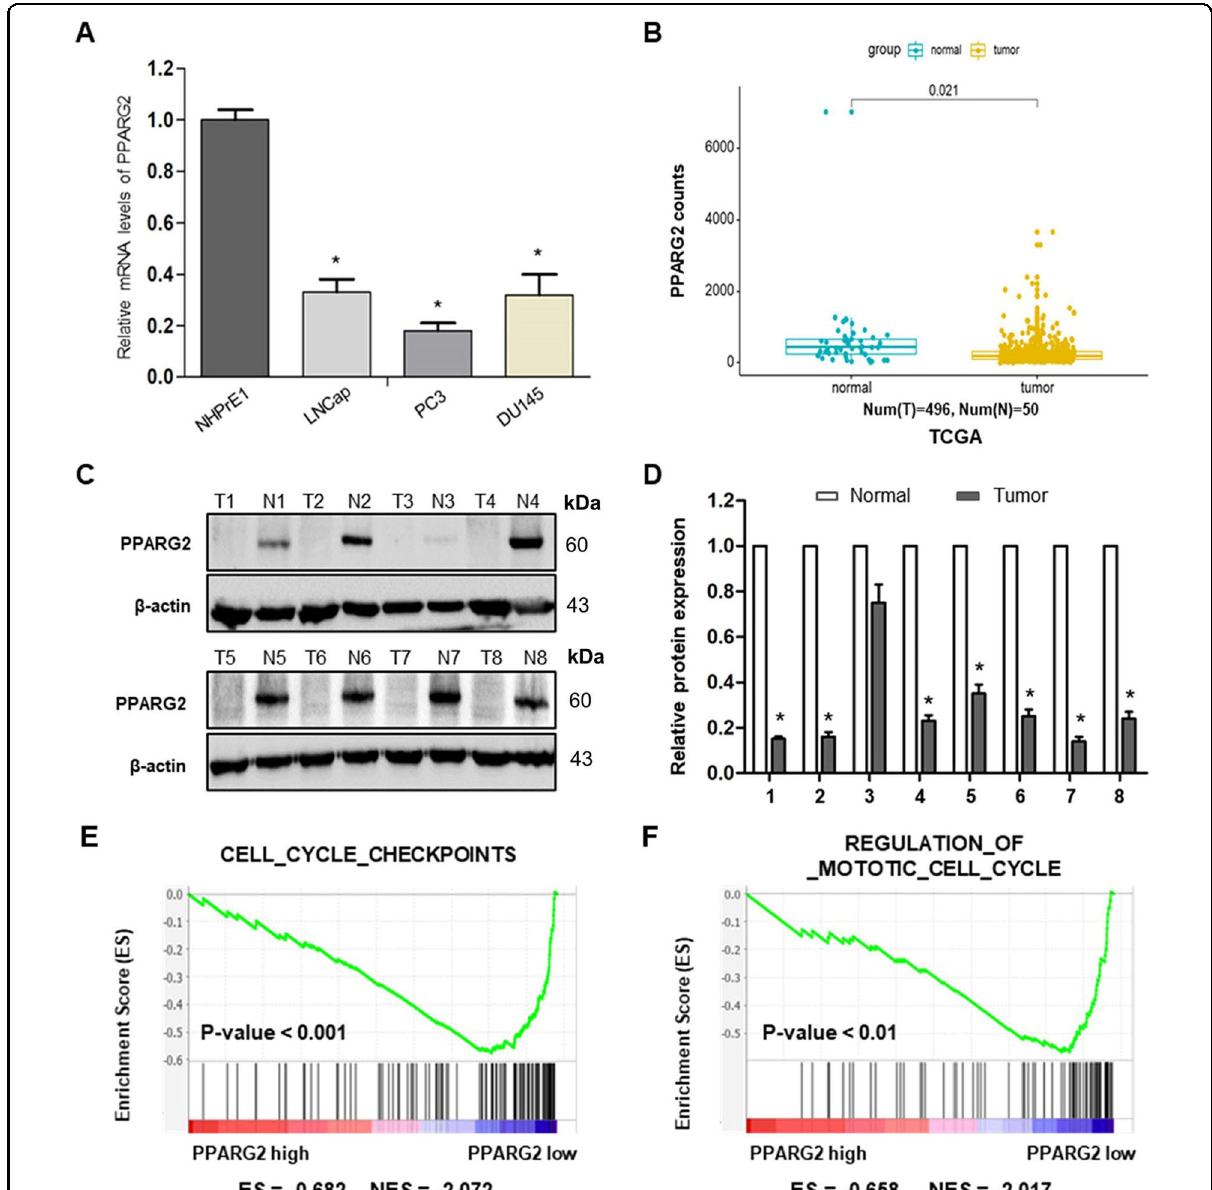
Fig. 1 PPARG2 is downregulated in PCA, negatively correlated with cell cycle-activated gene signatures. A Relative mRNA expression levels were analyzed in different PCA cell lines and a normal prostate epithelial progenitor cell line NHPrE1 by qRT-PCR. * P < 0.05 vs. normal group. B Expression of PPARG2 in 496 PCA tissues (tumor) compared with 50 normal tissues (normal) in the TCGA pro fi le. P = 0.021. C , D Western blotting analyses of relative PPARG2 protein expression in eight PCA tissues (T) and eight prostate hyperplasia tissues ( N ). * P < 0.05 vs. normal group. E , F GSEA plot showing the PPARG2 expression level correlated negatively with cell cycle-activated gene signatures (CELL_CYCLE_CHECKPOINTS,